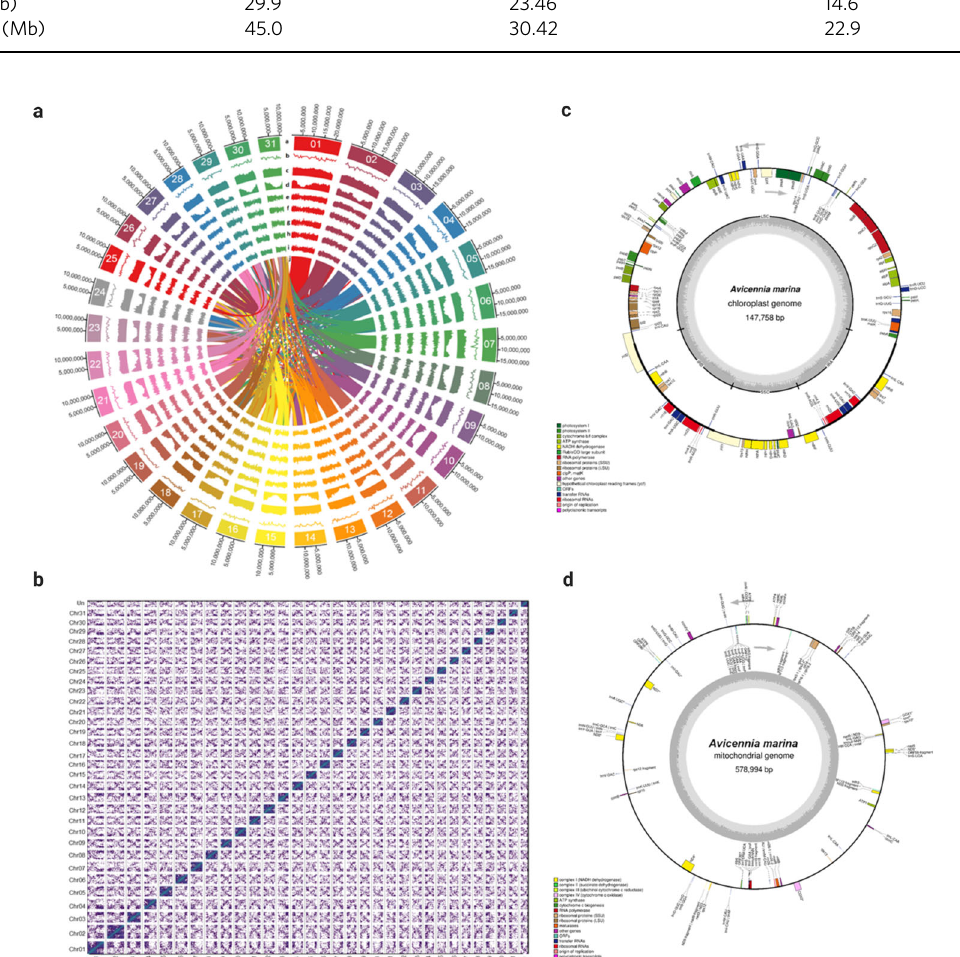
Fig. 3 Avicennia marina genome features. a Circos plot of the genome representing 31 chromosomes (a), distribution of the GC content (b), repeat content (c) and gene density (d) calculated in 0.5 Mb window size, expression pro fi le of the genes from leaves, roots, fl owers, pneumatophores, and seeds, respectively (e – i), and synteny blocks from intrachromosomal links (j). The bandwidth is proportional to synteny block size. Source data are provided as a Source Data fi le. Circular representation of chloroplast genome. b Hi-C interaction matrix for A. marina genome assembly with 32 clusters. c Circular representation of chloroplast genome. d Circular representation of the mitochondrial